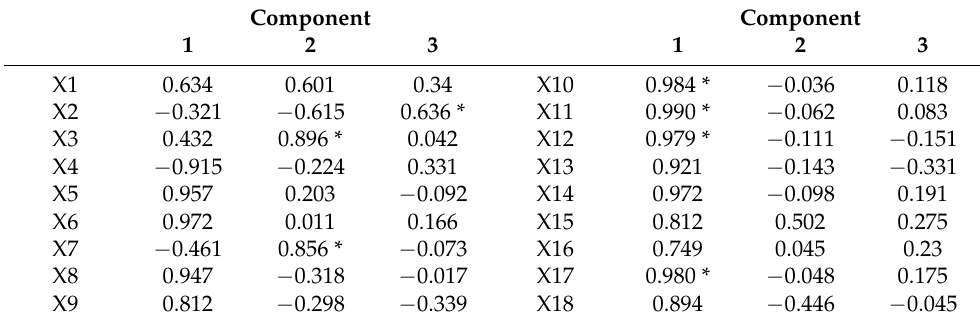
Table 5. Principal component load